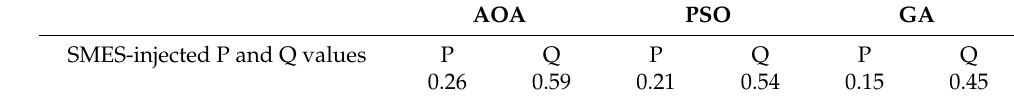
Table 9. SMES-injected active and reactive power for (L-L) scenario.